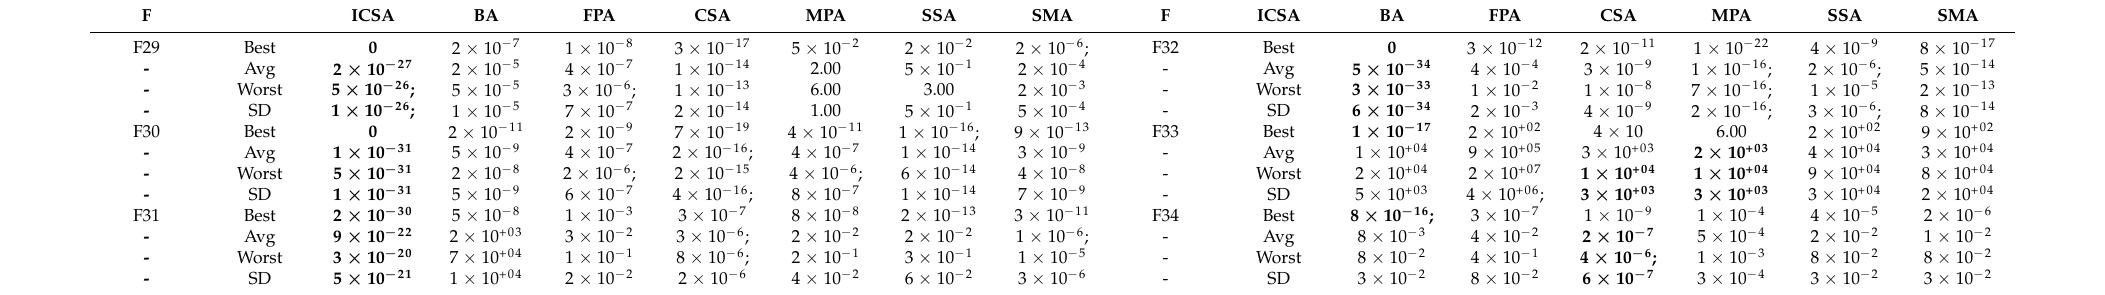
Table 4. Comparison among algorithms based on the objective values for test cases